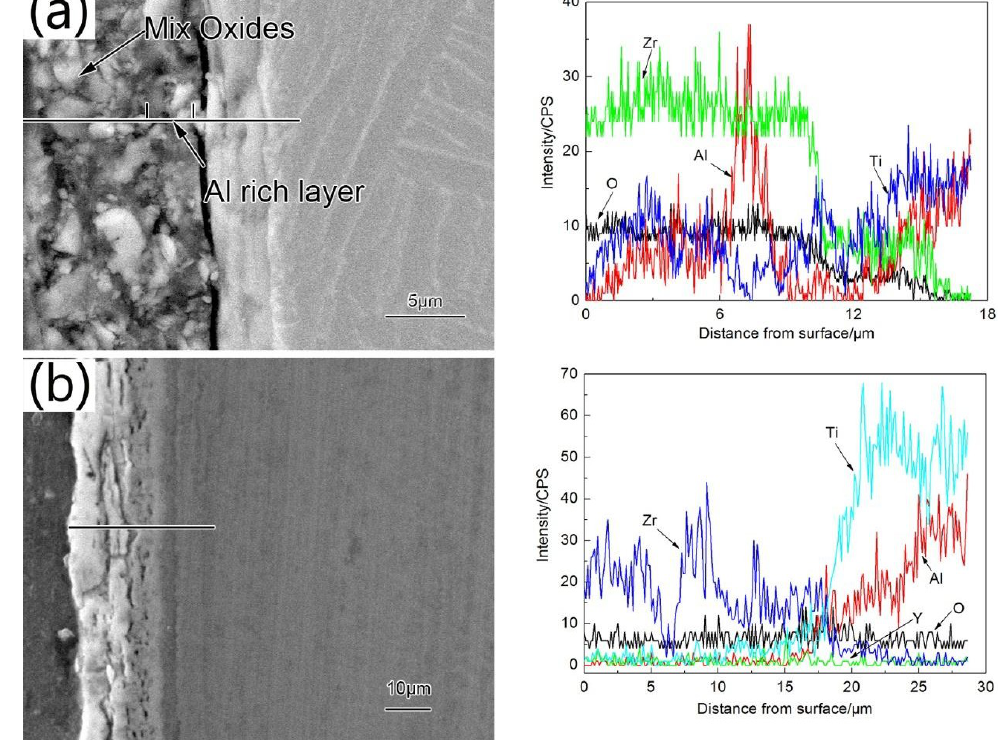
Figure 12. Surface morphology and EDS pattern of specimens at 850 °C for 100 h: ( a ) TiAl substrate; ( b ) Zr coating; ( c ) Zr-Y coating.